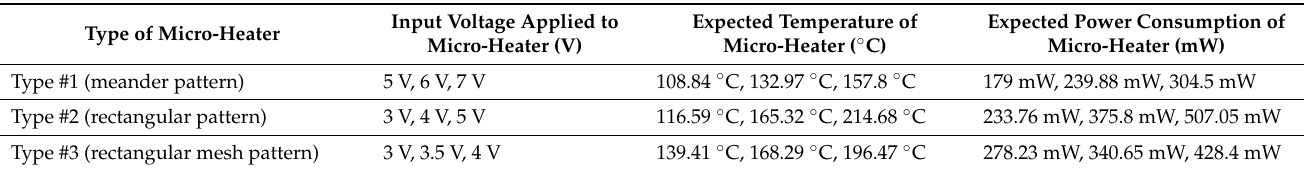
Table 1. Expected temperature and power consumption of micro-heaters with various geometric designs as a function of the applied input voltage of micro-heaters.